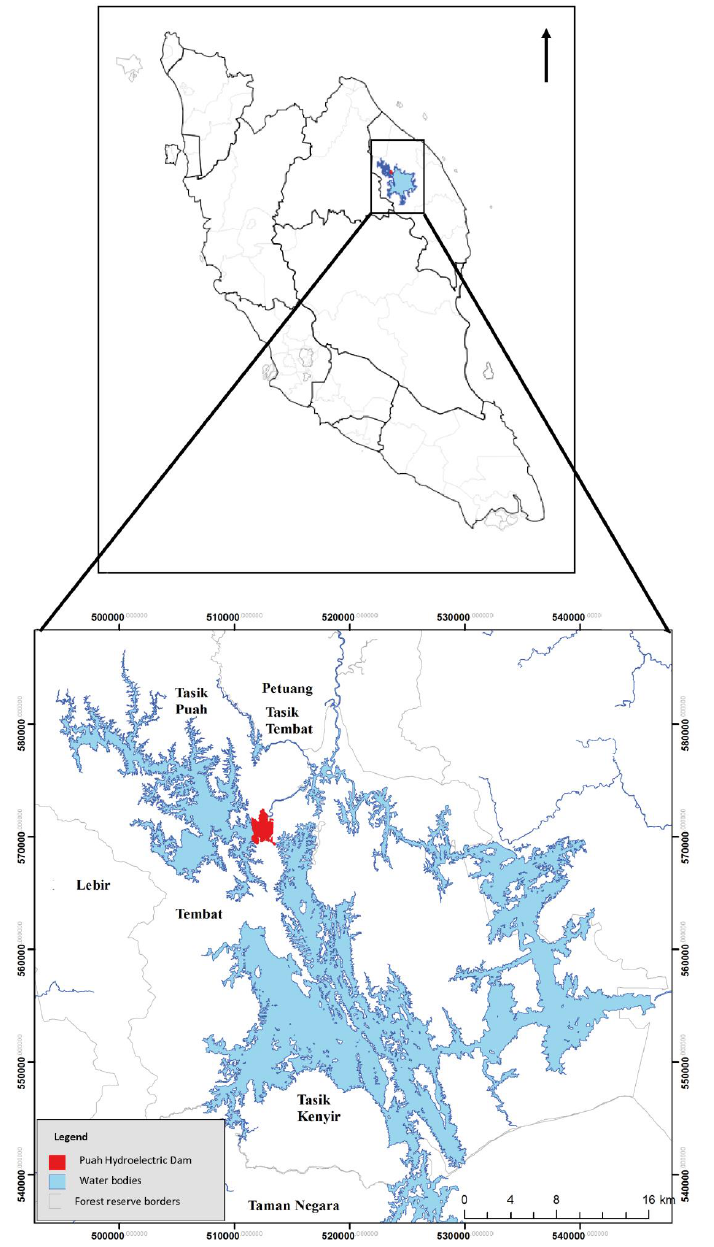
Figure 1. Study area, Tembat Forest Reserve, Terengganu, Peninsular Malaysia.